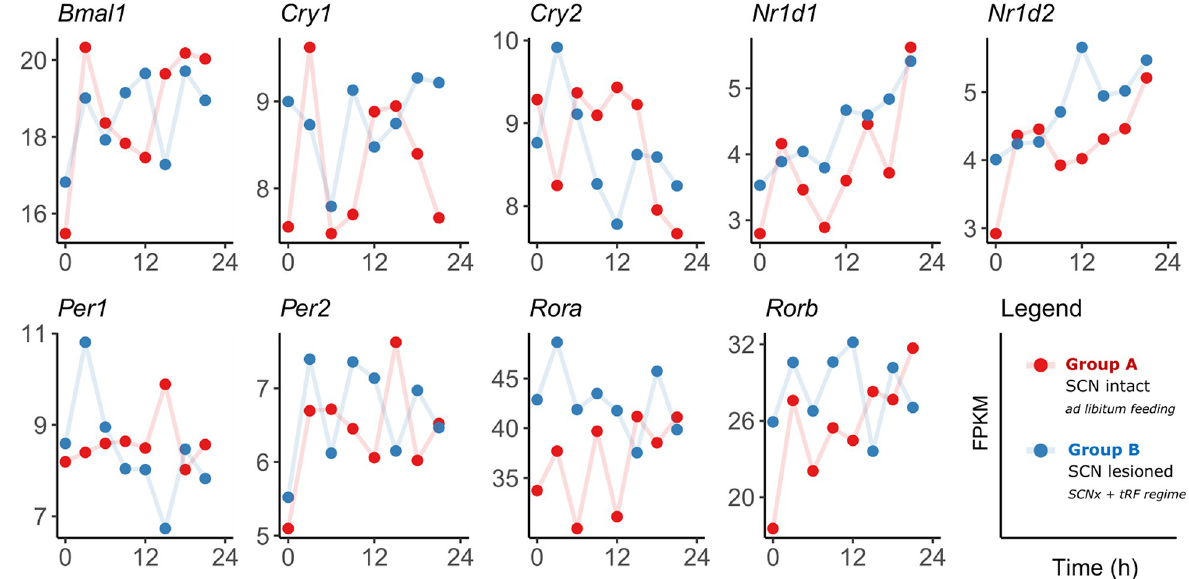
Fig 3. Temporal expression pattern of canonical clock in the E19 fetal rat SCN in Group A (SHAM, ad libitum, red) and Group B (SCN-X, tRF, blue). For raw data, see NCBI’s GEO GSE183172. SCN, suprachiasmatic nuclei.